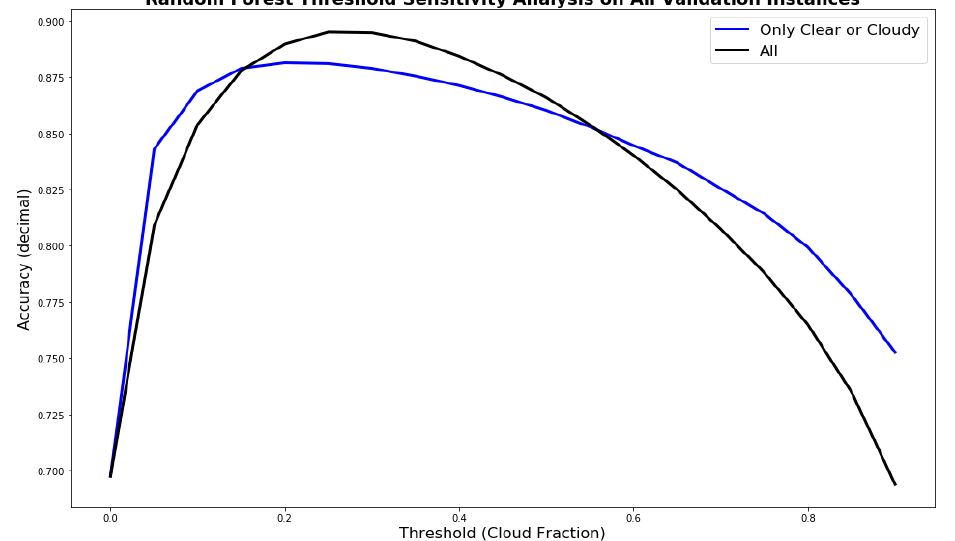
Figure 6. Sensitivity study for determining the optimal threshold for determining clear (0) versus cloudy (1) with training on either all instances or just the clear or completely cloudy instances. The optimal threshold was determined to be 0.25 for the training dataset with all instances.